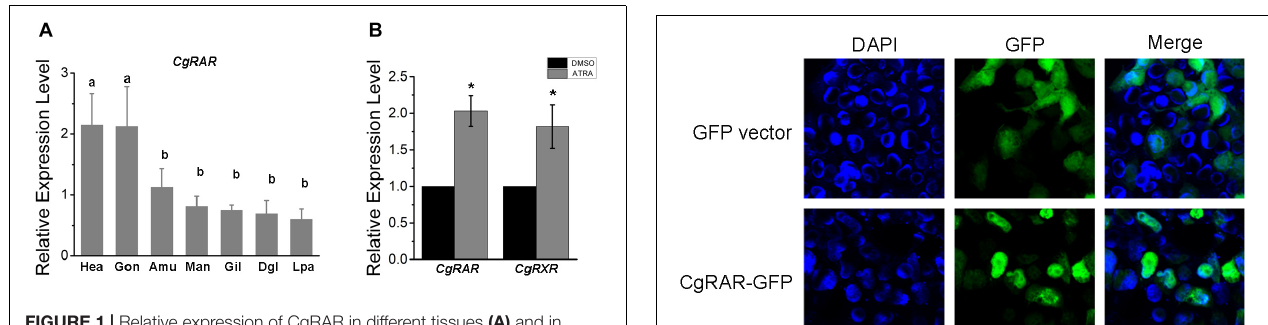
FIGURE 1 | Relative expression of CgRAR in different tissues (A) and in response to retinoic acid (RA) treatment (B) . Relative mRNA expression levels of CgRAR and CgRXR was normalized to that of CgRS18 . Bars represent means of three replicates ± SD (standard deviation). One-way ANOVA and Student’s t -test (* P < 0.05) were used for significance analysis in (A,B) respectively. Hae, hemolymph; Gon, gonad; Amu, adductor muscles; Man, mantle; Gil, gill; Dgl, digestive gland; Lpa, labial palps.